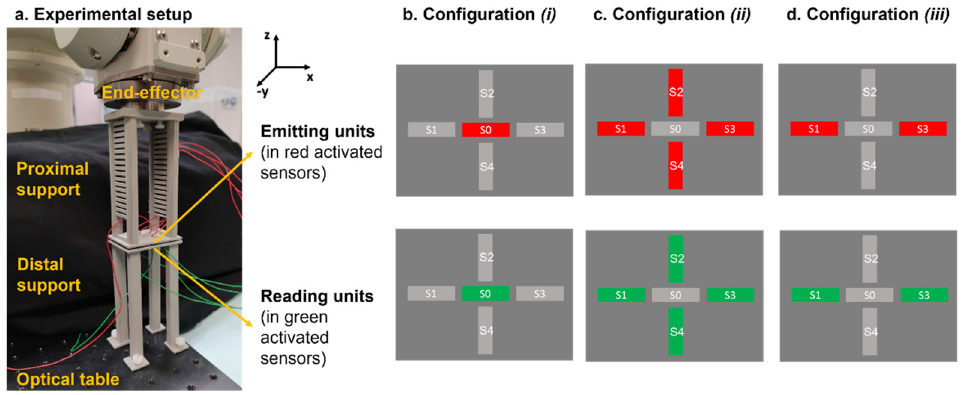
Figure 5. Experimental setup for characterizing the capacitive sensor technology.